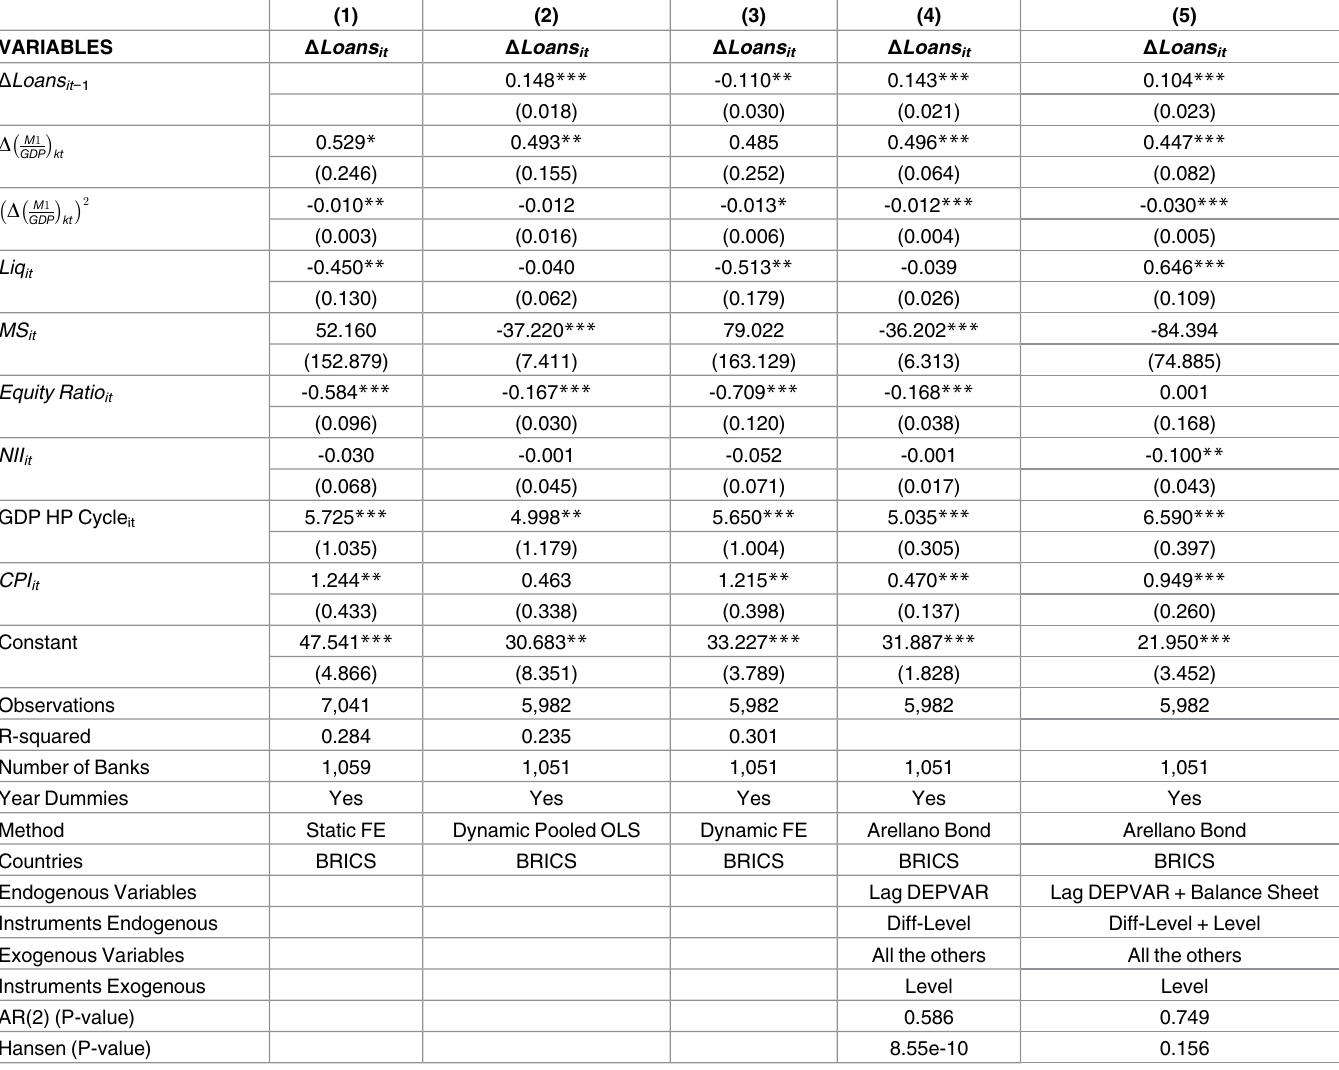
Table 2. Regression of Bank’s Loan Growth on Monetary Expansion D M1